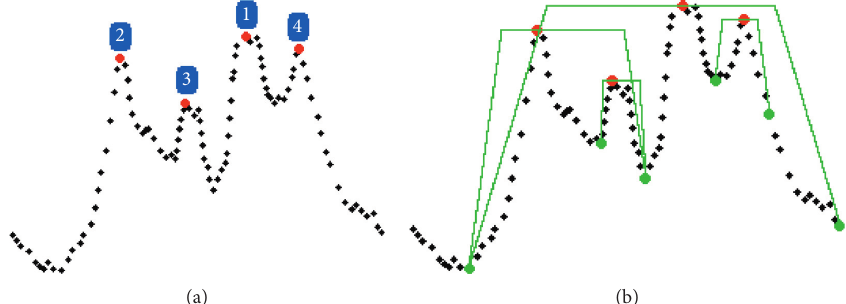
Figure 7: (a) The 4 peak points detected. (b) The supporting hills of the peak points, where each supporting hill is illustrated by a bottom- open trapezoid with the top line passing the peak point and the 2 base points specifying the range of the